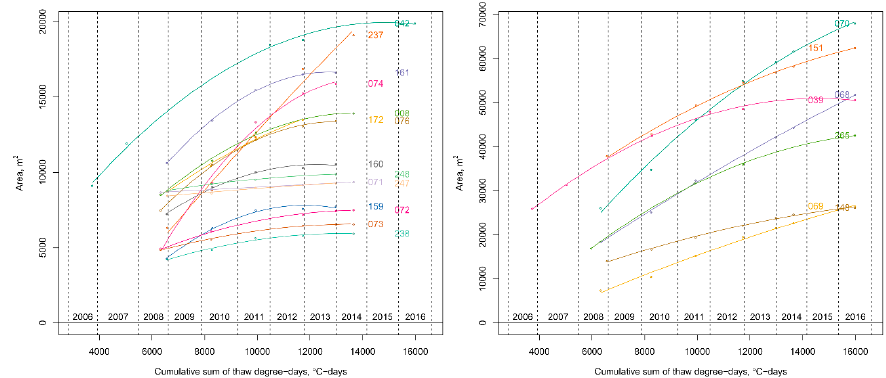
Figure 7. Slump areas vs. cumulative thaw degree-days (TDDs), ( left ) for large slumps with final areas greater than 2 to 7 ha; and ( right ) for small slumps with final areas of 0.5 to 2 ha. TDDs were measured at the Noatak RAWS and accumulated from an arbitrary start date of 1 January 2004. The vertical dashed lines mark winters (when TDD did not accumulate for multiple months), and the intervening thaw-season years are labeled. Curves are quadratic with regression coefficients in Table S6. The 3-digit numbers, coded by color, identify the slumps (Figure 2).